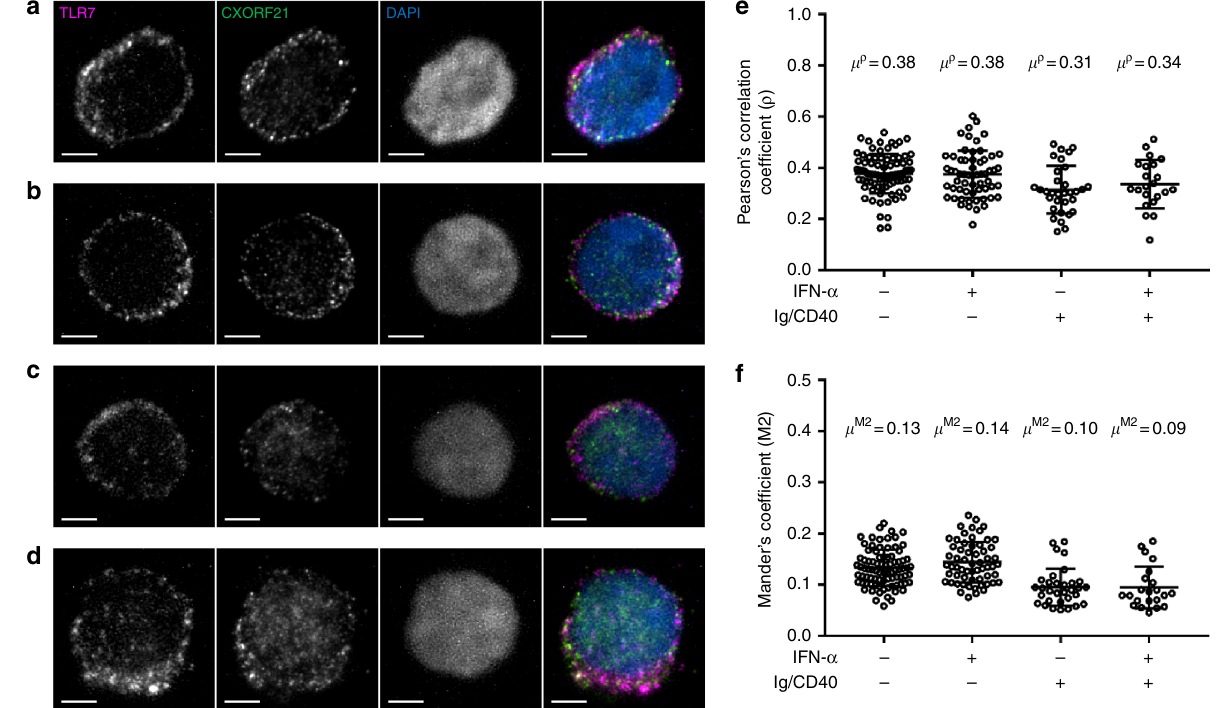
Fig. 6 Super resolution microscopy of CXORF21 and TLR7. Structured Illumination Microscopy data showing colocalisation of TLR7 and CXORF21 in ex vivo B cells. Representative results on individual cells are shown in a through D with TLR7 staining in the fi rst column, CXORF21 in the second column, DAPI nuclear staining in column three, and in the fourth column all three stains are merged: TLR7 (magenta), CXORF21 (green) and DAPI (blue). The B cells are under different conditions in the panels: a resting, b resting and IFN- α treated (1000 U/ml), c Ig/CD40 stimulated and d Ig/CD40 stimulated and IFN- α treated ex vivo B cells at 20 h. Maximum intensity projections are shown. Scale bar in white on bottom left hand corner is 2 µ m. e Plot showing the correlation co-ef fi cients ( ρ ) between TLR7 and CXORF21 staining of multiple B cells quanti fi ed using the results from Z-stack images from individual cells (represented as open circles). From left to right: unstimulated cells ( n = 84), cells stimulated with IFN- α ( n = 60), B cells stimulated with Ig/CD40 ( n = 32), B cells stimulated with Ig/CD40 and IFN- α ( n = 22). The horizontal bar represents the mean correlation co-ef fi cient ( μ ρ ) and the bars above and below this denote the standard deviation of the distribution. f Mander ’ s colocalisation coef fi cient (M2) between TLR7 and CXORF21 are shown from Z- stack images from single B cells (represented as open circles). From left to right: unstimulated cells ( n = 84), cells stimulated with IFN- α ( n = 60), B cells stimulated with Ig/CD40 ( n = 32), B cells stimulated with Ig/CD40 and IFN- α ( n = 22). The horizontal bar represents the mean colocalisation co-ef fi cient ( μ M2 ) and the bars above and below this denote the standard deviation of the distribution. Source data are provided as a Source Data fi